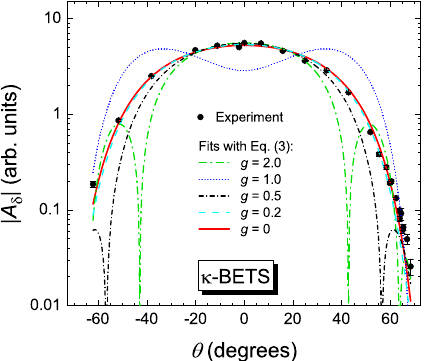
Fig. 3 Angular dependence of the SdH amplitude A δ in the AF state of κ -BETS. The lines are fi ts using Eq. (3) with different values of the g -factor. The vertical error bars are determined by the signal- to-noise ratio of the corresponding FFT